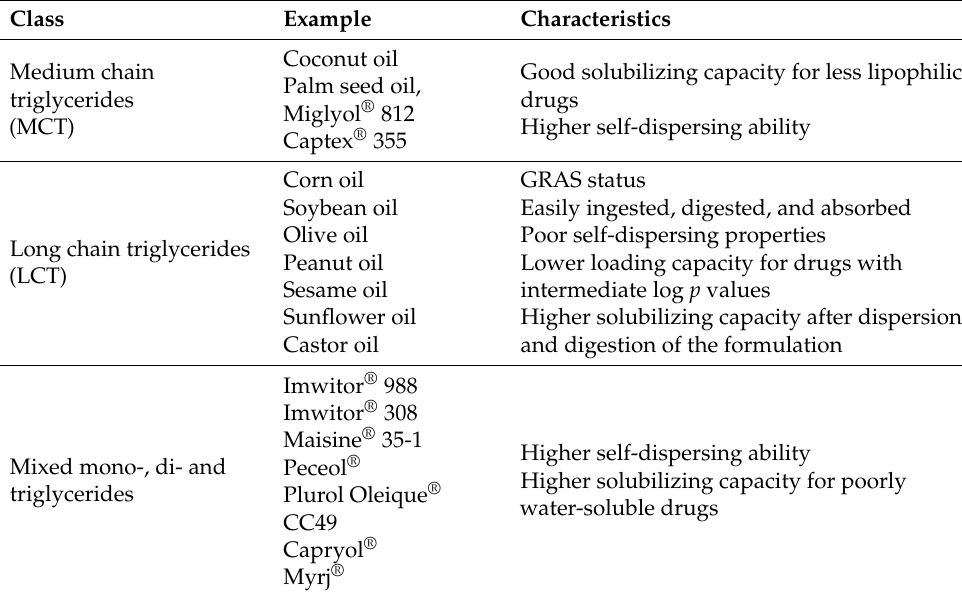
Table 2. The characterizations of different types of glycerides used in lipid-based formulations